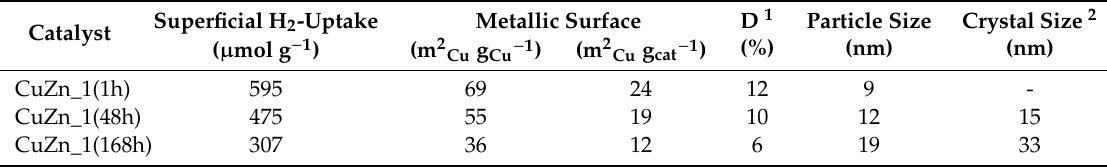
Table 6. Metallic characteristic of CuZn_1 catalysts synthesized with di ff erent aging time. determined from N 2 O